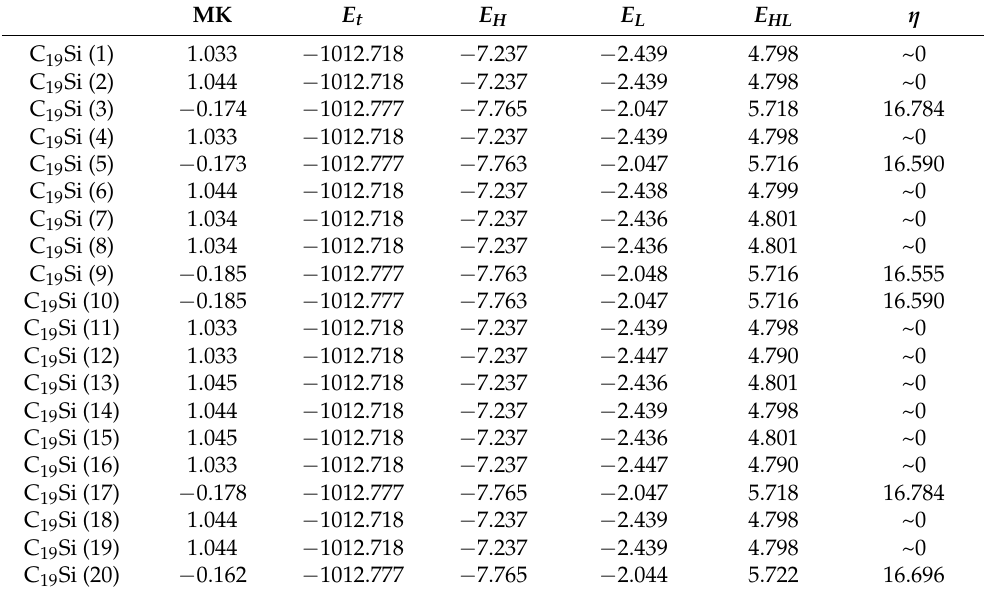
Table 1. MK charges on the Si-atom, total energy, E t , (in a.u.) HOMO energy, E H , LUMO energy, E L , and HOMO-LUMO energy gap E HL , (in eV) also shown for discussion in the text. The last column presents the relative population, η in %, of each of the geometrical conformers calculated using the Boltzmann distribution at 298.15